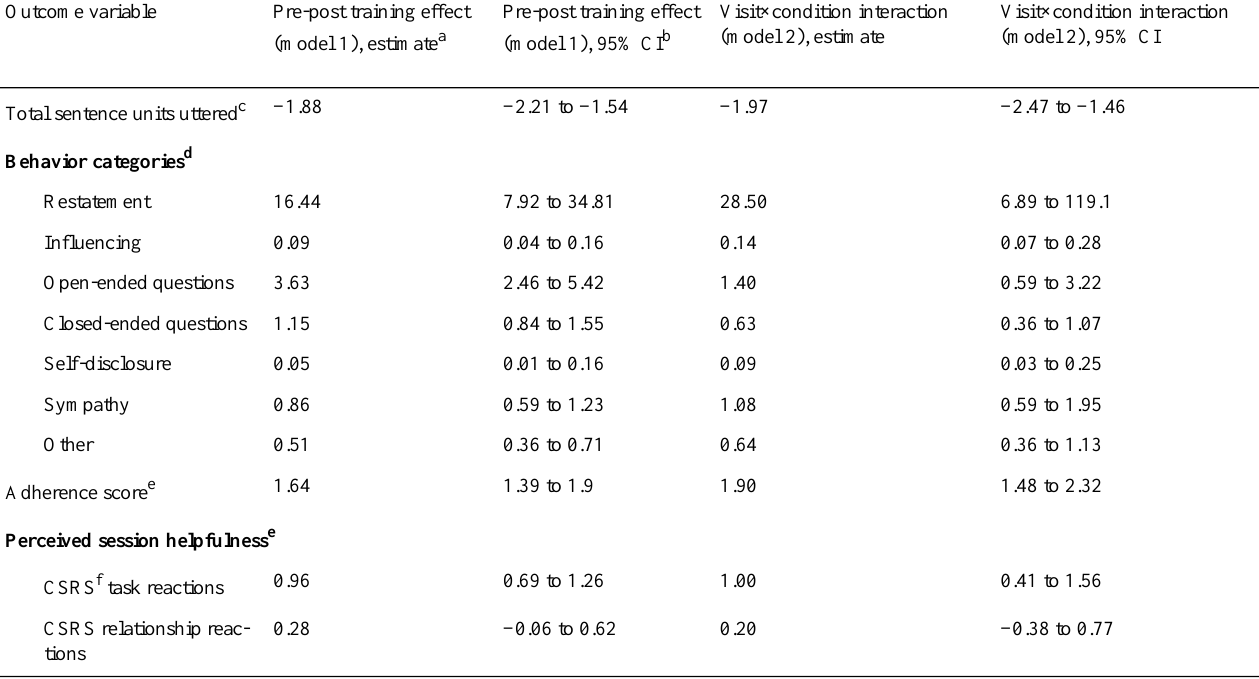
Table 3. Results of Bayesian multilevel models estimating change from pretraining to posttraining among all participants (model 1) and the difference between the 2 conditions in change from the first to second laboratory visits (model